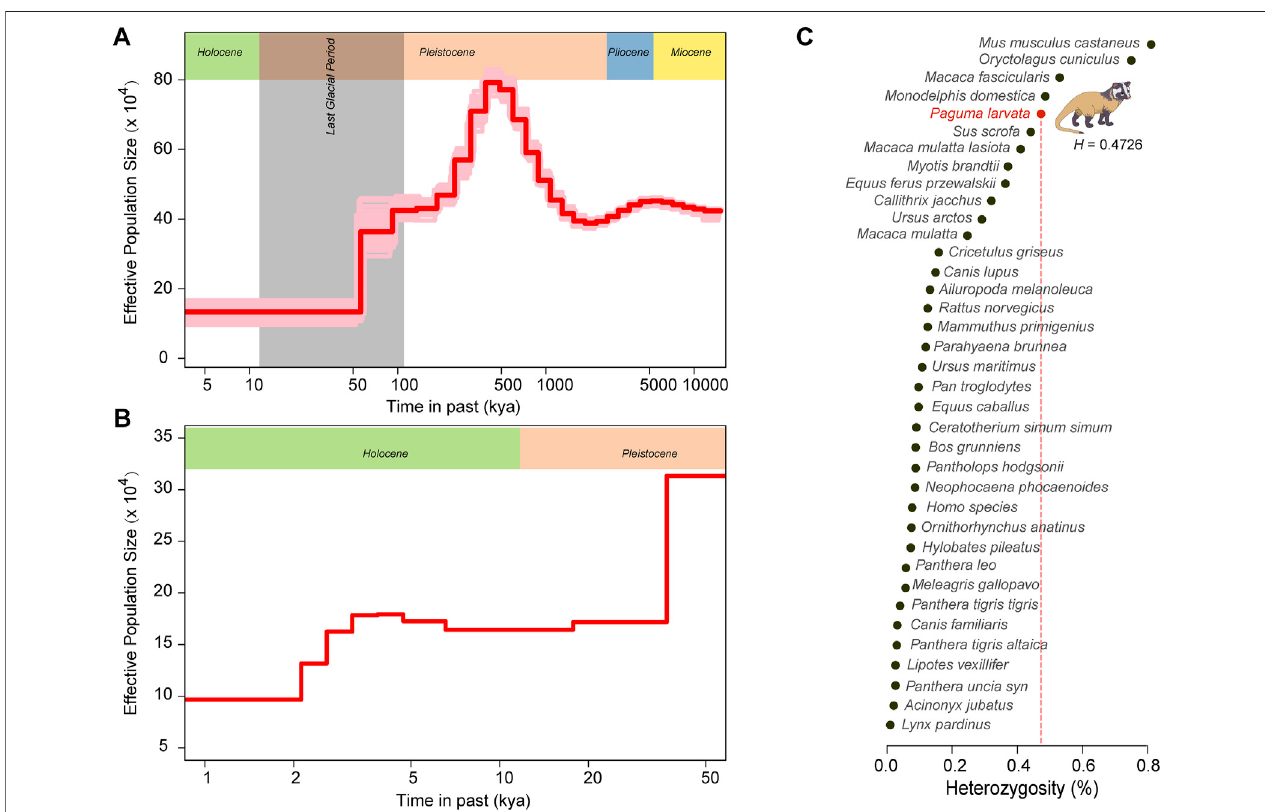
FIGURE5| Genomic heterozygosityandpopulationhistoryofthe P.larvata . (A) Demographichistoryof P.larvata estimatedbyPSMC. (B) Demographichistoryof P. larvata estimated by SMC++. (C) The genome-wide heterozygosity in P. larvata and 36 other published species. The generation interval and mutation rate we used here were 2 years and 2.4 × 10 – 9